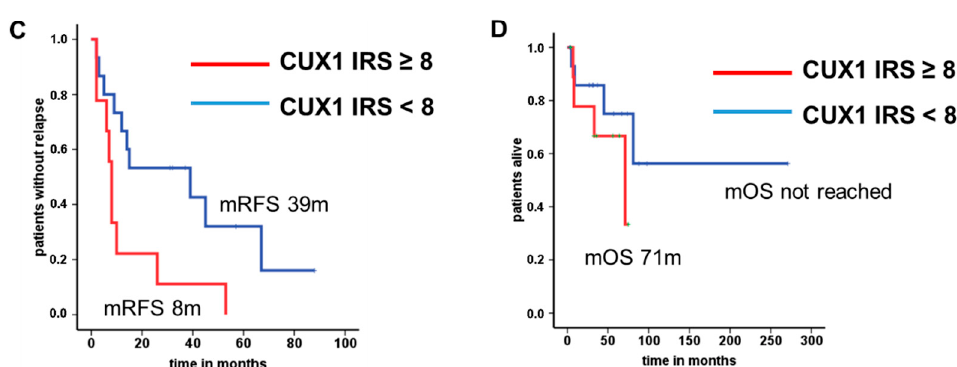
Figure 1. ( A ) Cut homeobox 1 (CUX1) immunoreactivity score (IRS) in patients with metastases ( n = 40; mean: 5.6 ± 0.78 SEM) and primary tumours ( n = 104; mean: 7.5 ± 0.48 SEM), * p = 0.038. ( B ) CUX1 IRS with recurrence ( n = 19; mean: 5.8 ± 1.3 SEM) and no-recurrence ( n = 5; mean: 3.2 ± 1.2 SEM) P =